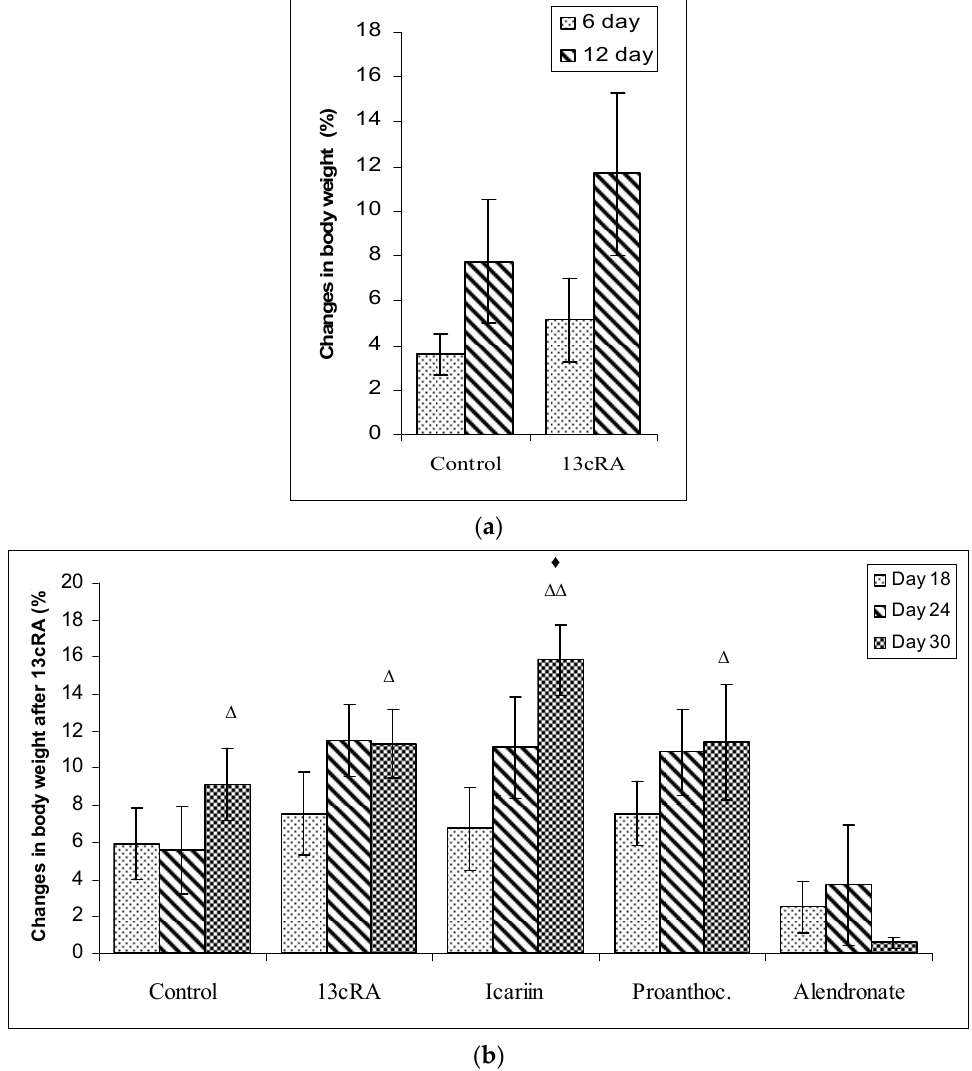
Figure 1. Changes in body weight at different time points: ( a ) during treatment with retinoic acid, ( b ) effect of icariin, proanthocyanidins and alendronate on the body weight change in rats after retinoic acid-induced bone loss. Rats were administered ig with retinoic acid suspension (80 mg kg − 1 ) once daily for 14 days. After inducing osteoporosis with 13cRA, rats were administered ig with icariin (100 mg kg − 1 ), proanthocyanidins (100 mg kg − 1 ) or alendronate (40 mg kg − 1 ) once daily for next 14 days. The animals were weighed just before the start of the experiment (starting weight of animals 225–250) and during the experiment on days 6, 12, 18, 24 and 30. The percentage change in weight was calculated for individual animals as Percentage change in weight = Final weight-Initial weight × 100/Final weight. Number of rats per group: 7. ♦ Statistically significantly different compared to control ( ♦ p < 0.05) on day 30. ∆ Statistically significantly different compared to alendronate ( ∆ p < 0.05; ∆∆ p < 0.01) on day 30.